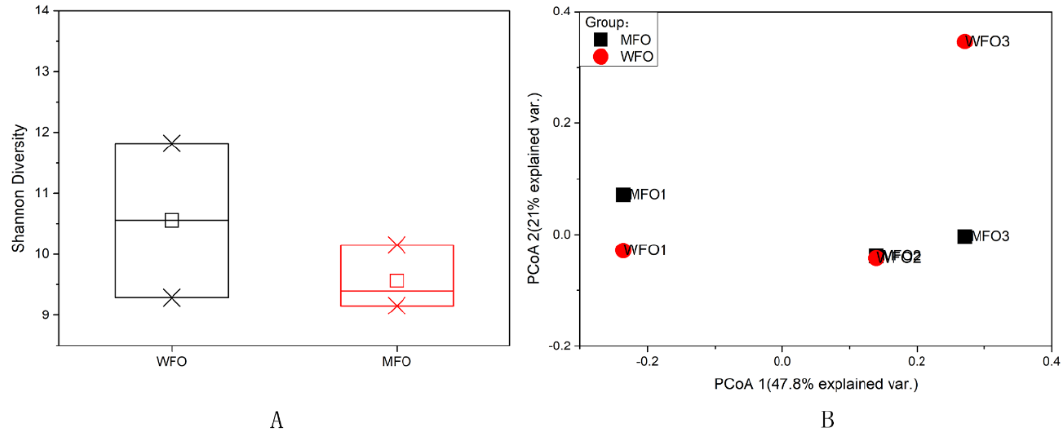
Figure 8. Viral community diversity analysis. ( A ) Shannon diversity index of viral communities. ( B ) PCoA of viral communities in the production wells of the water and microbial flooding block.